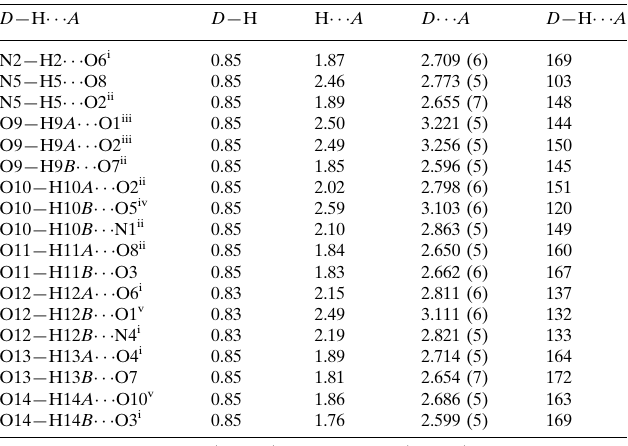
Hydrogen-bond geometry (A˚ , (cid:4)